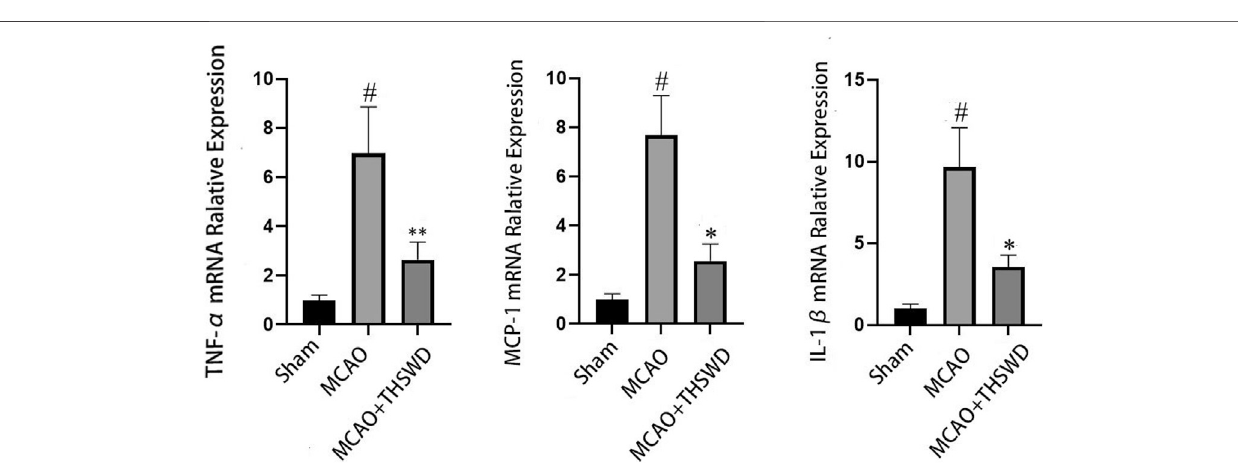
Frontiers in Pharmacology |